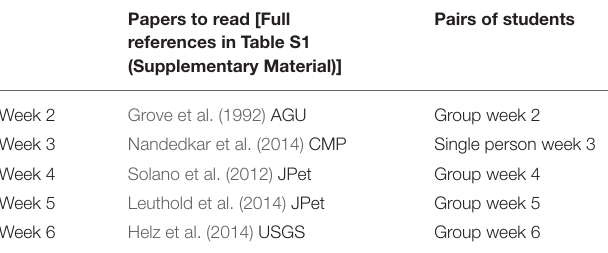
TABLE 1 | Selection of scientific papers offered to the